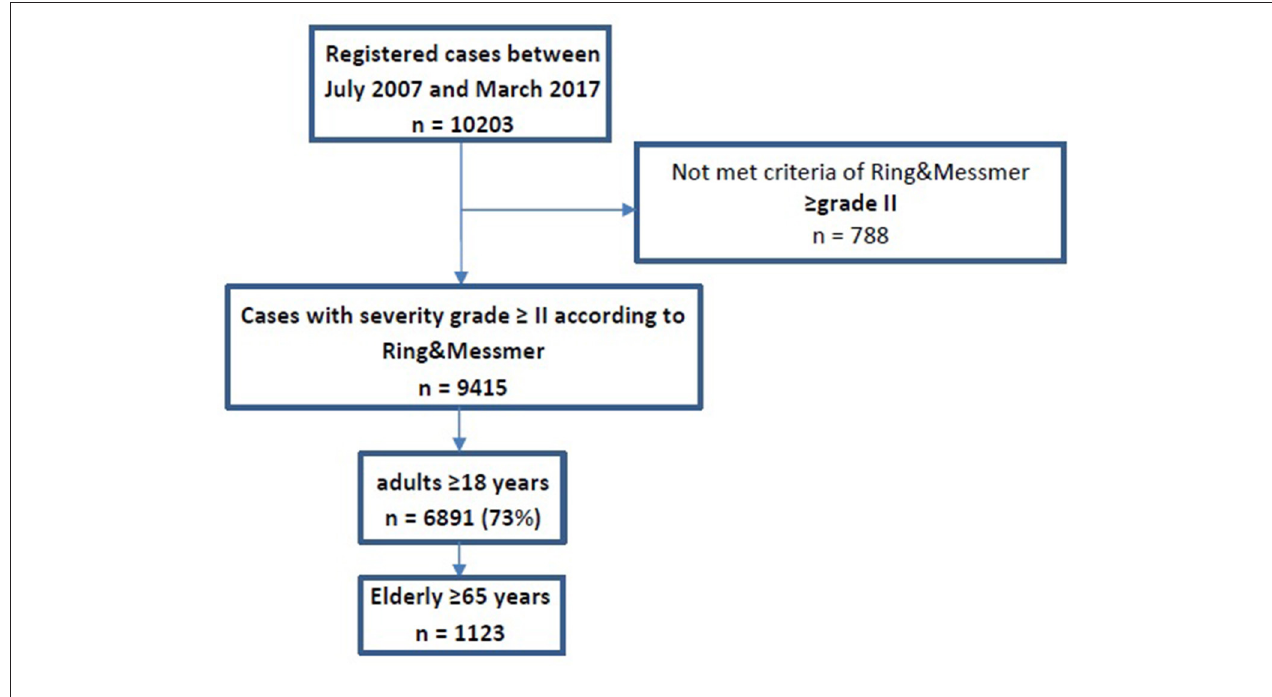
FIGURE 1 | Flow chart of study cohort.